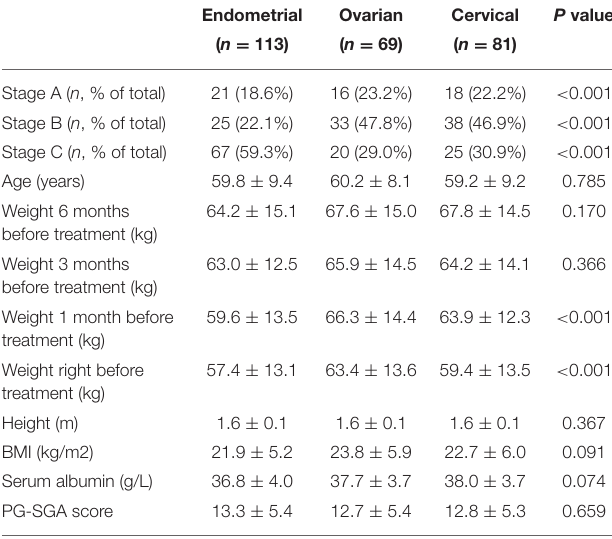
TABLE 2 | Characteristics of patients with endometrial, ovarian and cervical